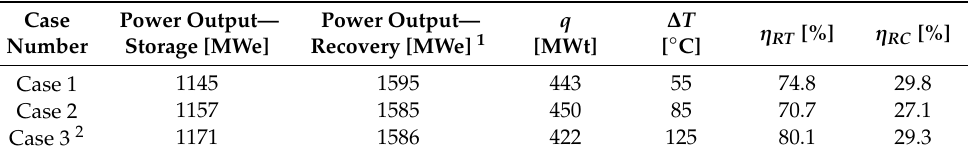
Table 2. APR1400 NHS&R Case E ffi ciency.